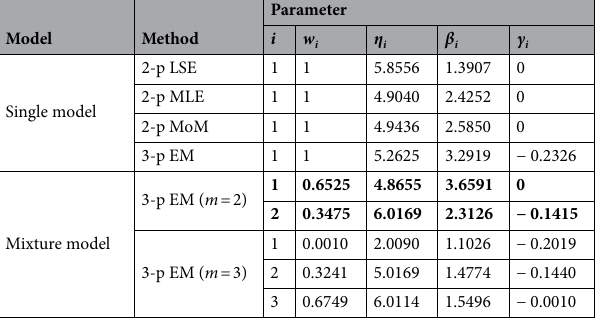
Table 2. Parameter estimation results of wind speed model with 2-parameter and 3-parameter Weibull distributions using different methods. Two-parameter and three-parameter are abbreviated as 2-p and 3-p, respectively. The results of the best model are in bold